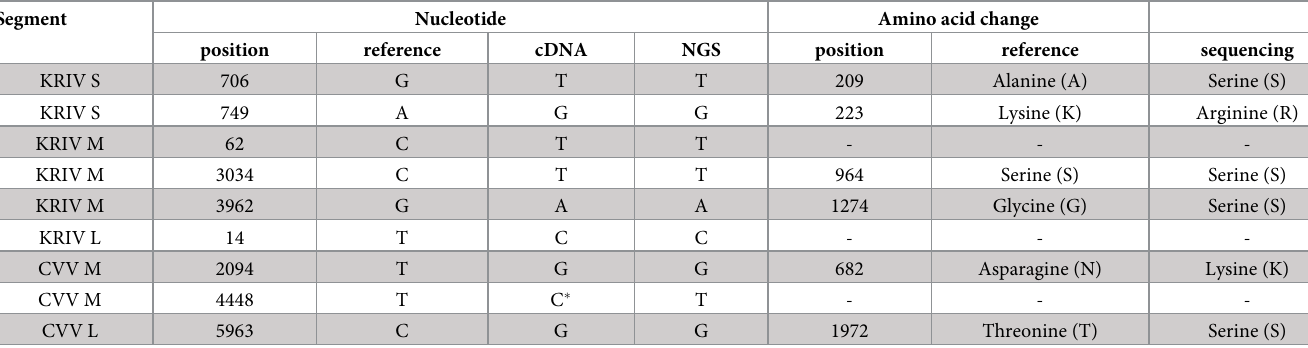
Table 2. Nucleotide and amino acid sequence comparisons.